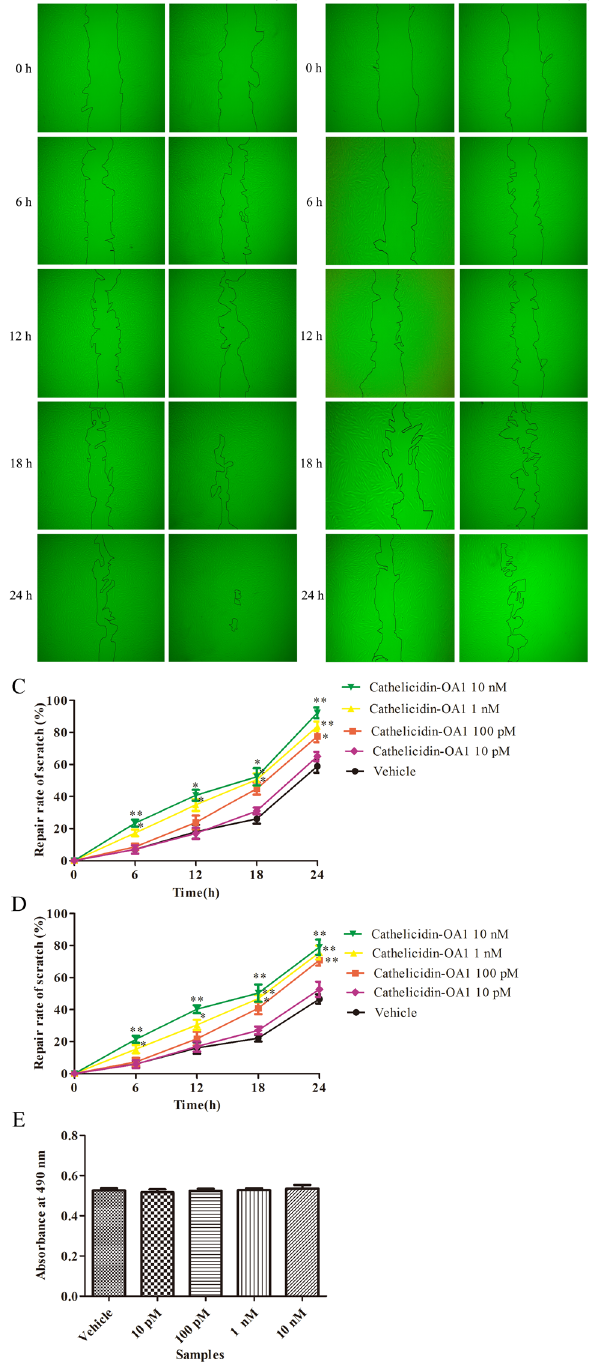
Figure 6. Effect of cathelicidin-OA1 on the repair rate of HSF cell wounds (scratches). ( A ) Cathelicidin-OA1 (10 nM) illustrated obvious HSF cell wound-healing activity. ( B ) Cathelicidin-OA1 (10 nM) illustrated HSF cell wound-healing activity when proliferation was inhibited by mitomycin C. ( C ) Cathelicidin-OA1 illustrated time- and dose-dependent HSF cell wound-healing activity. ( D ) Cathelicidin-OA1 illustrated time- and dose- dependent HSF cell wound-healing activity when proliferation was inhibited by mitomycin C. ( E ) At 10 pM to 10 nM, cathelicidin-OA1 showed no effect on the proliferation of HSF cells. ‘Vehicle’ is the negative control; * P < 0.05 and ** P < 0. 01 indicated significantly different from the vehicle (Student’s t- test). Data are mean values of three independent experiments performed in